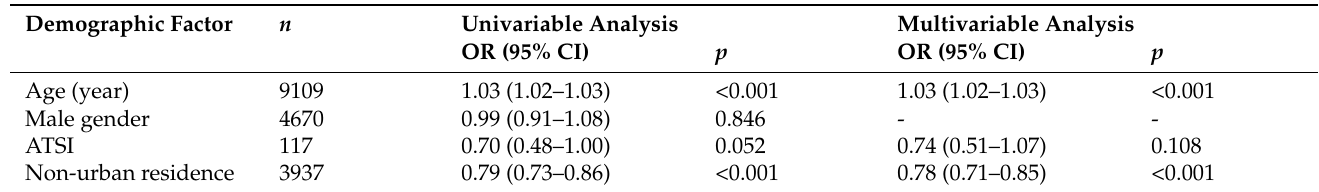
Table A7. Univariable and multivariable analyses of demographic factors associated with lipid-lowering therapy adherence.